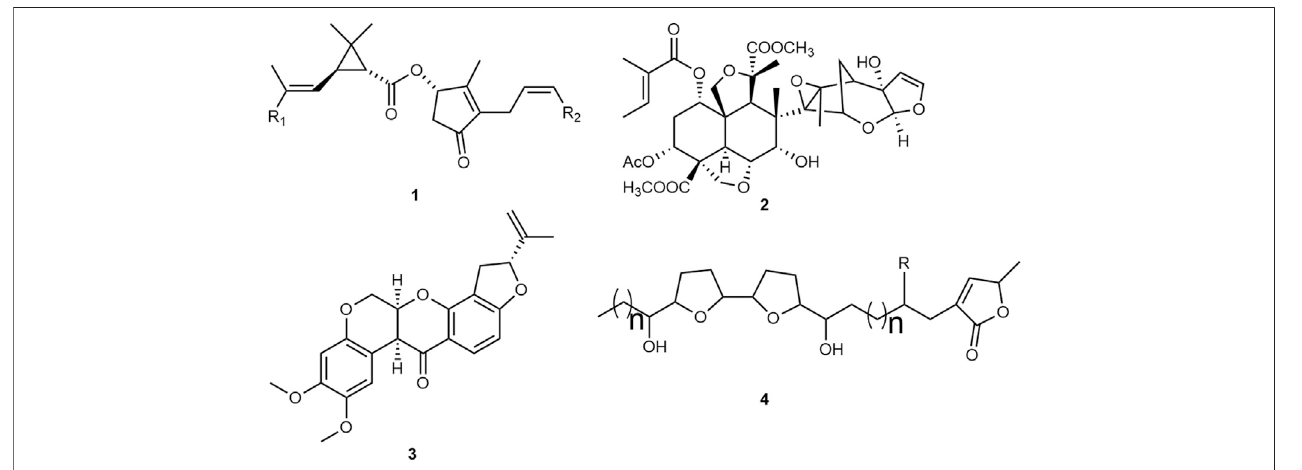
FIGURE 1 | Molecules isolated from plants used as insecticides: pyrethrins 1; azadirachtin 2; rotenone 3, and acetogenins 4.